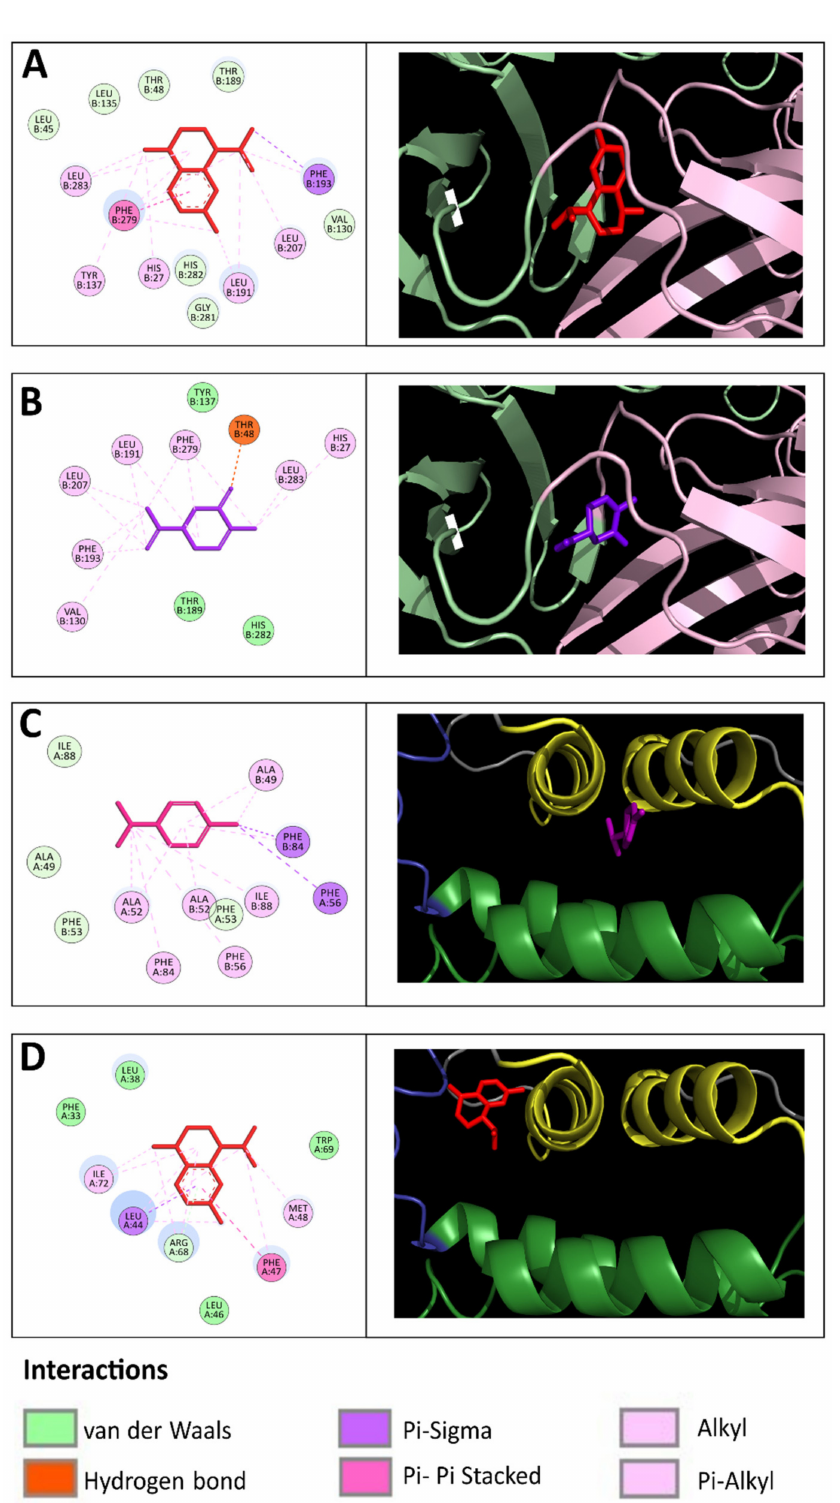
Figure 5. Lowest-energy docked poses of sesquiterpenes and monoterpenes with DENV-2 proteins. Docked cis -calamenene ( A ) and carvone ( B) in complex with E protein showing bonds with amino acids at the hinge region. ( C ). Docked α -phellandrene in complex with C protein showing bonds with amino acids at the α 2- α 2 (cid:48) dimer interface hinge region. ( D ). Docked cis -calamenene in complex with C protein showing bonds with amino acids at the loop that connect α 1 and α 3